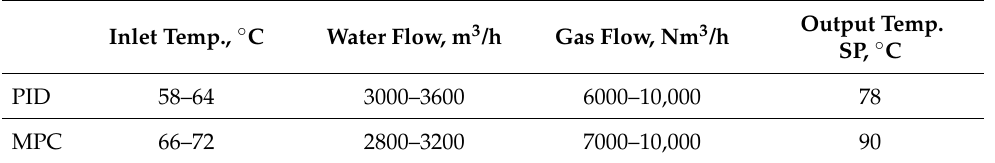
Table 3. A summary of the operating areas for the MPC- and PID-based control loops. The operating areas depend on the set point, and three inputs to the system. The control loops are compared according to the operating areas specified in the table.